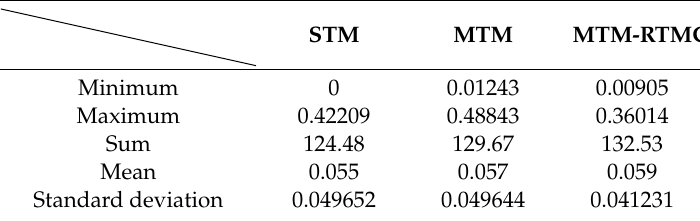
Table 3. The summary statistics of STM, MTM, and MTM-RTCM G2SFCA models’ results. STM